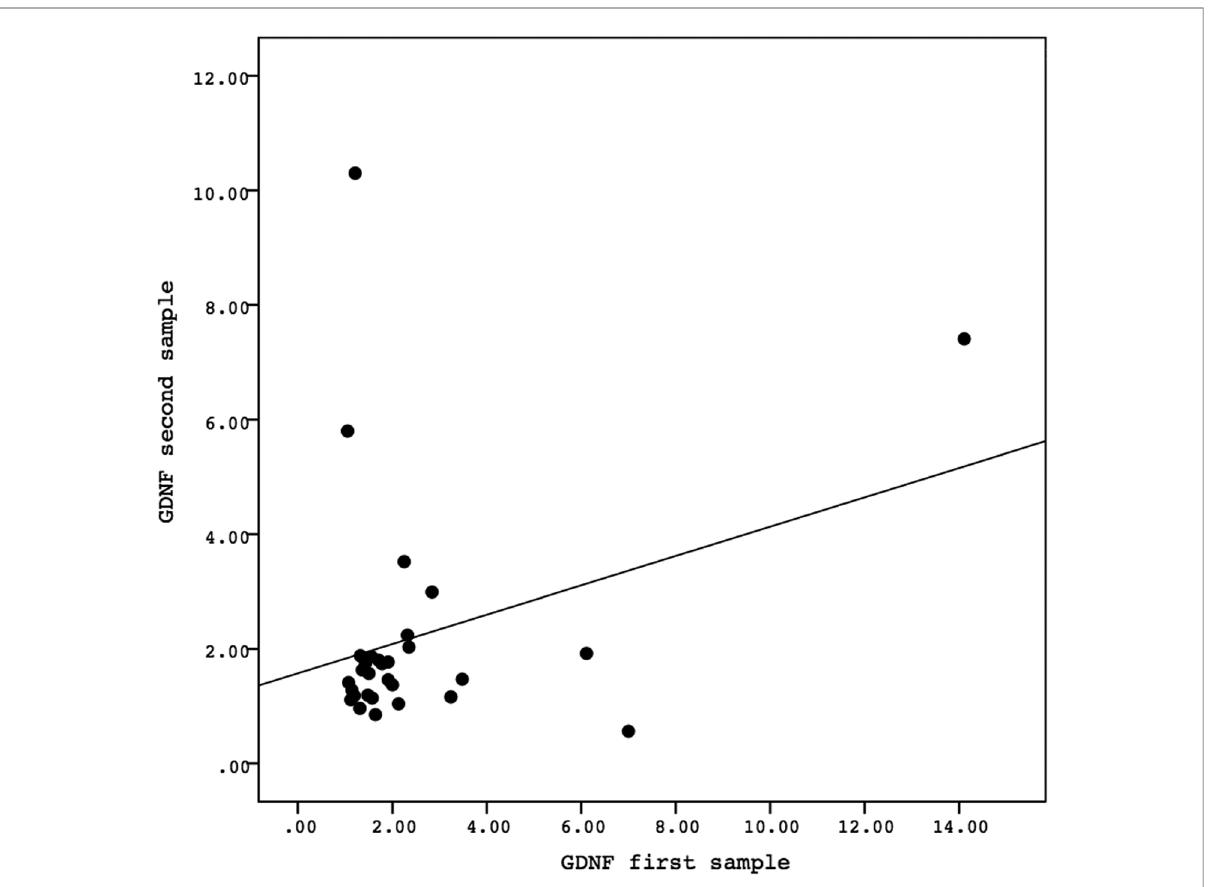
FIGURE 3 The correlation between the GDNF values of the fi rst sample and the second sample. Correlation analysis using Spearman correlation demonstrated the correlation coef fi cient ( r )=0.138 and P -value=0.468. GDNF, glial-derived neurotrophic